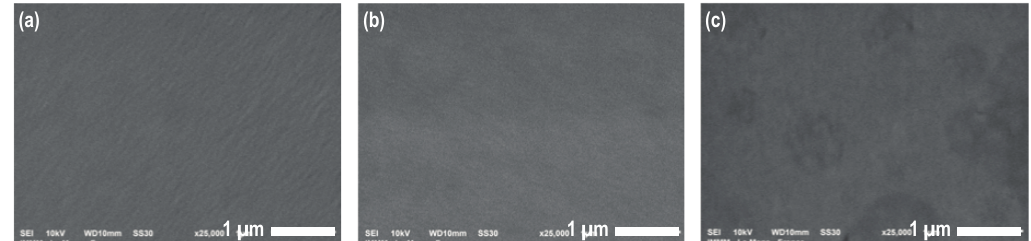
Figure A8. SEM evidence of the roughness of the (Bi 1 − x Pr x )(Fe 0.95 Mn 0.05 )O 3 surface deposited on LAO substrate for selected Pr substitution concentrations: ( a ) 10%, ( b ) 12.5%, and ( c ) 20%.